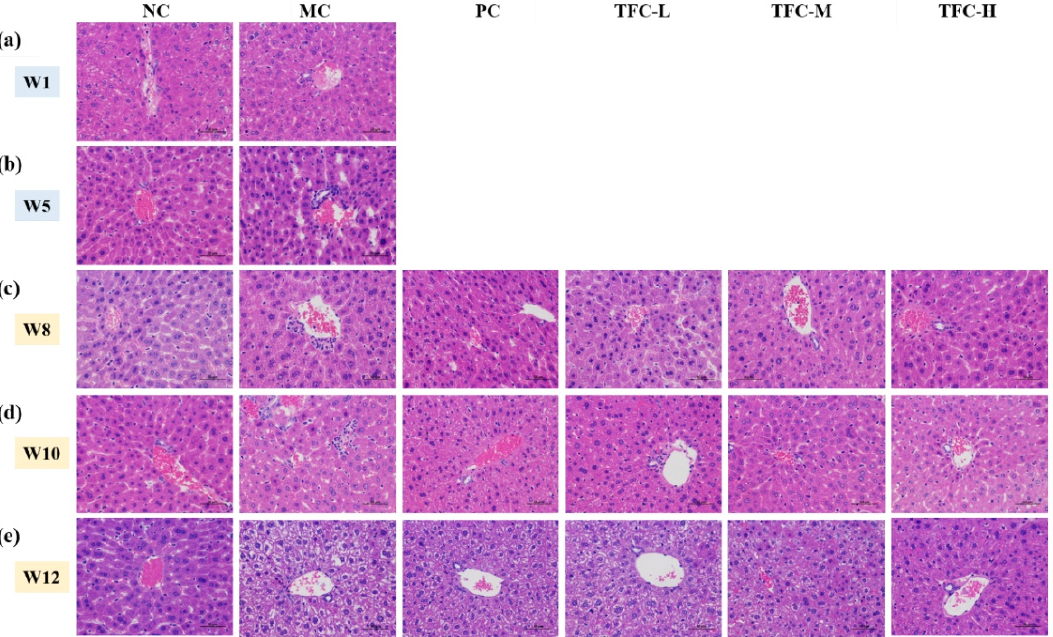
Figure 5. Representative images of liver H&E staining (400 × ) in different groups of mice. ( a )Hepatic histomorphology in the first week, ( b ) Hepatic histomorphology in the fifth week, ( c ) Hepatic his- tomorphology in the eighth week, ( d ) Hepatic histomorphology in the tenth week, ( e ) Hepatic histomorphology in the twelfth week.